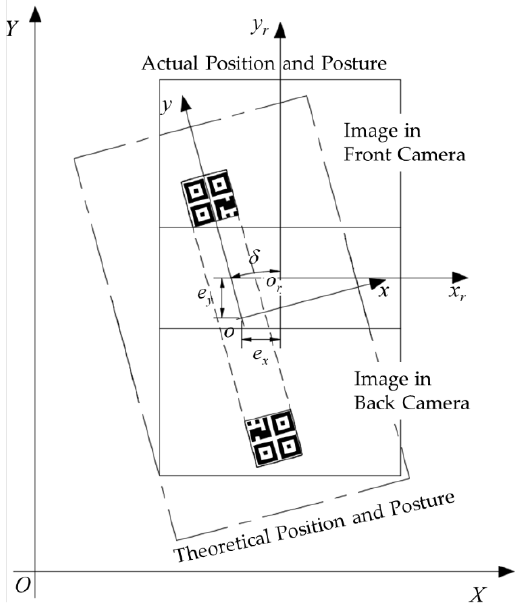
Figure 10. Schematic of the quick response (QR) code images in the two cameras when the platform is parked at a certain assembly station.